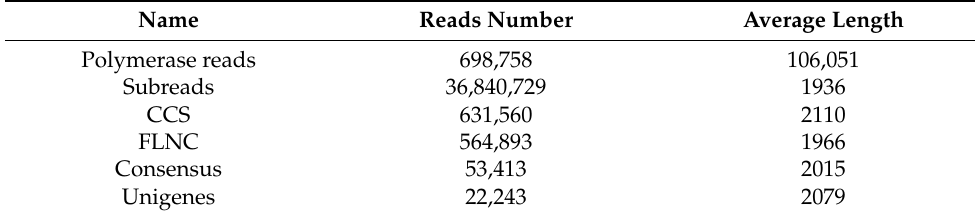
Table S1. The number of transcription factor annotations in Table S2. Table 1. Overview of Chinese fir PacBio platform